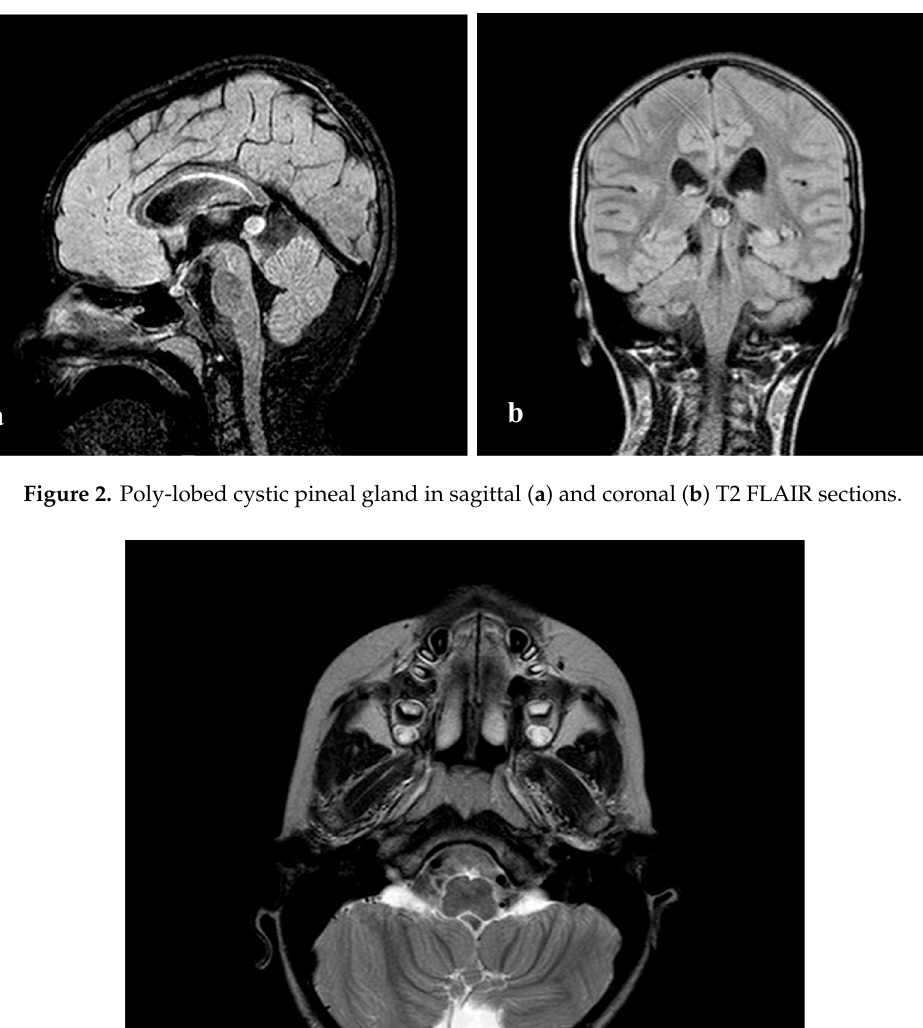
Figure 3. Retrocerebellar cystic ectasia in axial T2 weighted section.